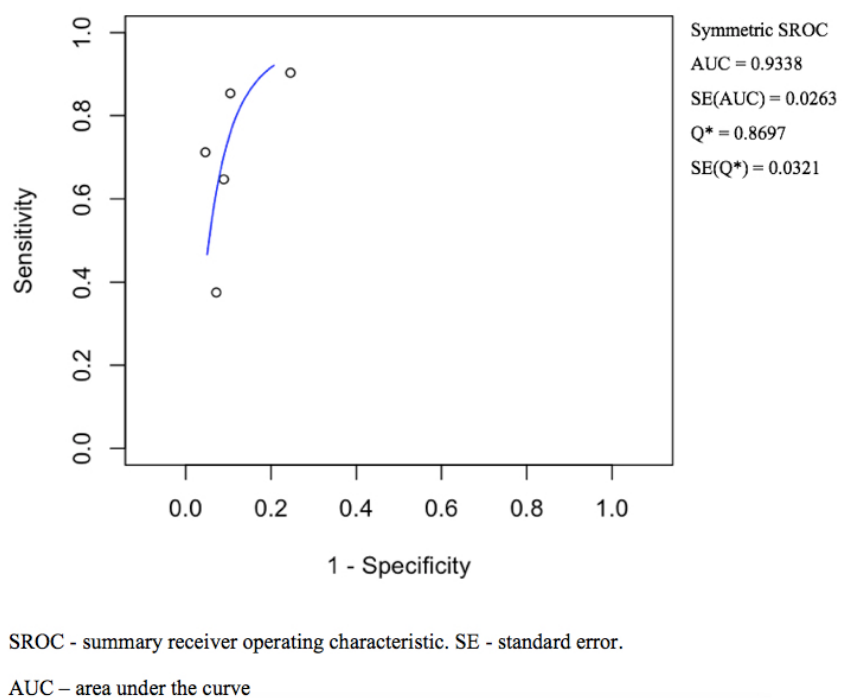
Figure 5. White light summary receiver operating characteristic curve illustrates the accuracy of nasoendoscopy with conventional white light settings. Area under the curve and standard error was calculated.